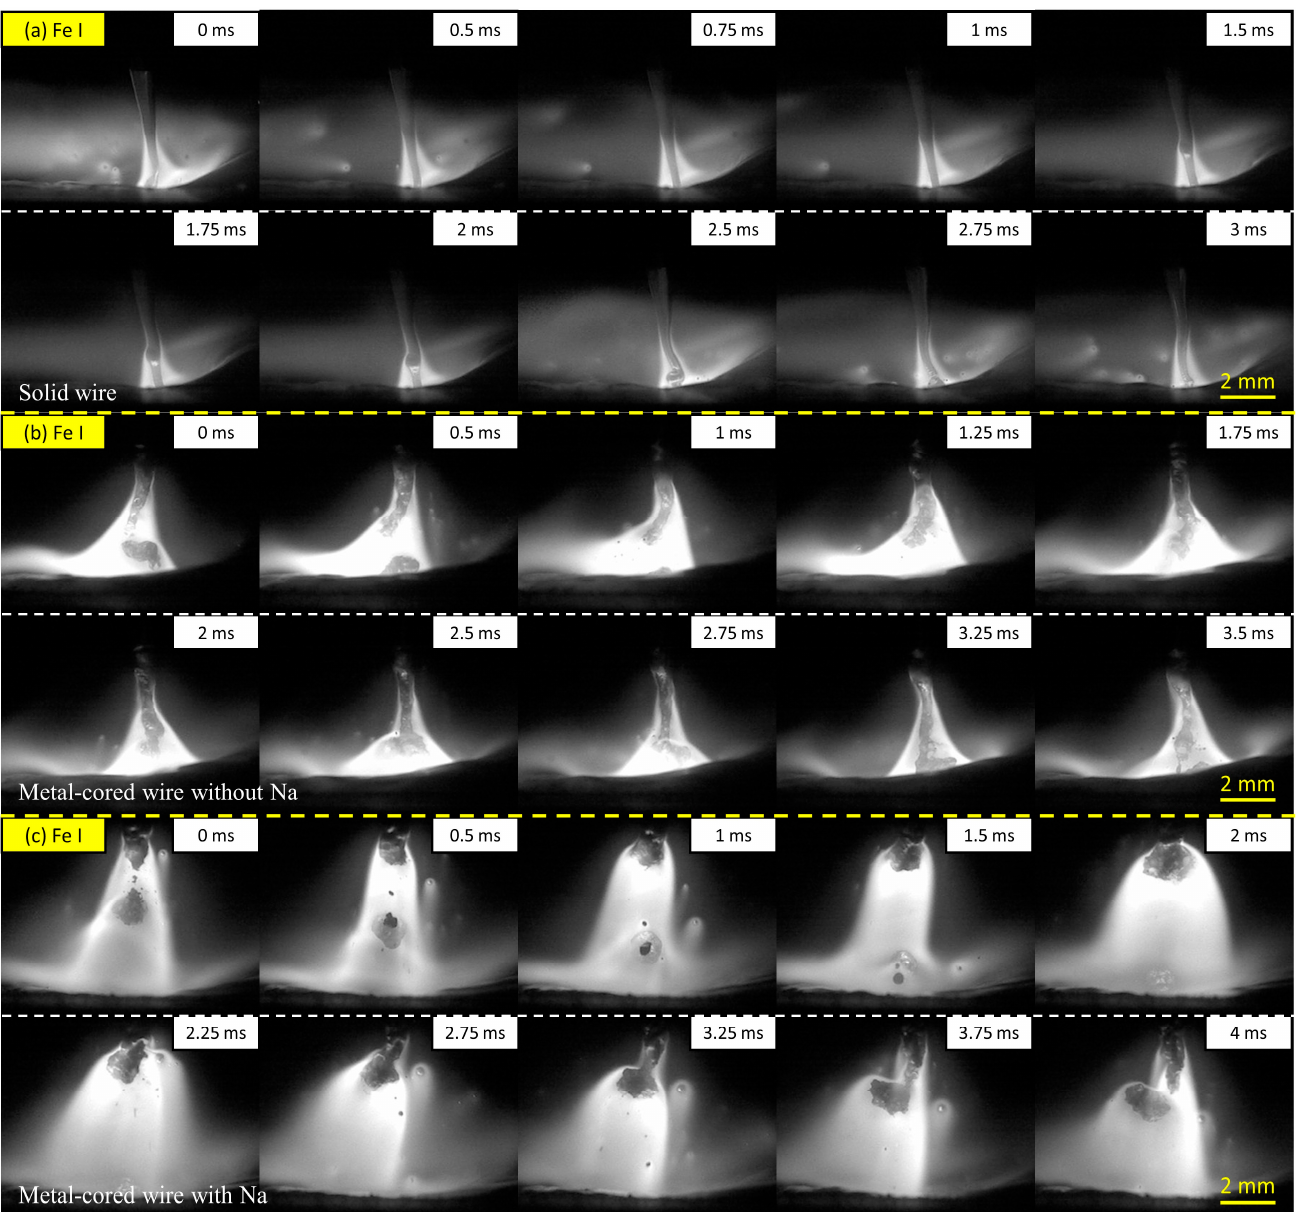
Figure 4. Metal transfer observation for wire 1 ( a ), wire 2 ( b ), and wire 3 ( c ) using the Fe I filter at 320 A of welding